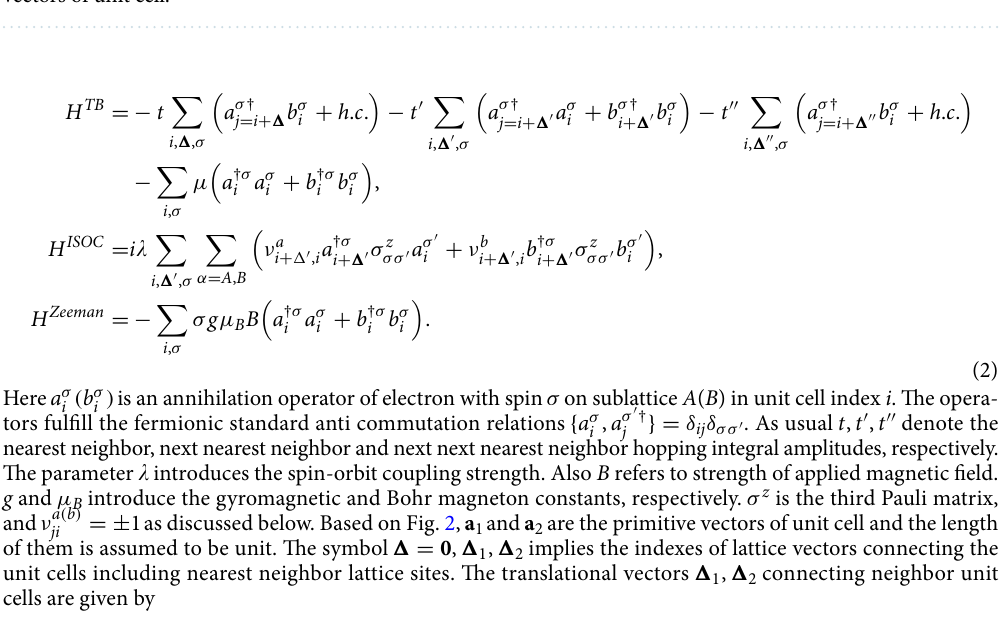
Figure 2. The structure of honeycomb structure is shown. The light dashed lines denote the Bravais lattice unit cell. Each cell includes two nonequivalent sites, which are indicated by A and B. a 1 and a 2 are the primitive vectors of unit